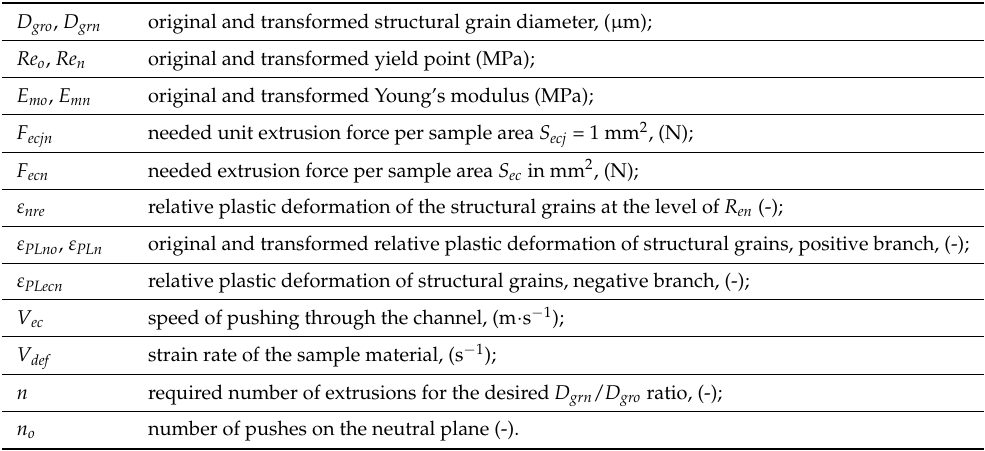
Figure 14. Evolution of the modulus of elasticity after individual extrusions.